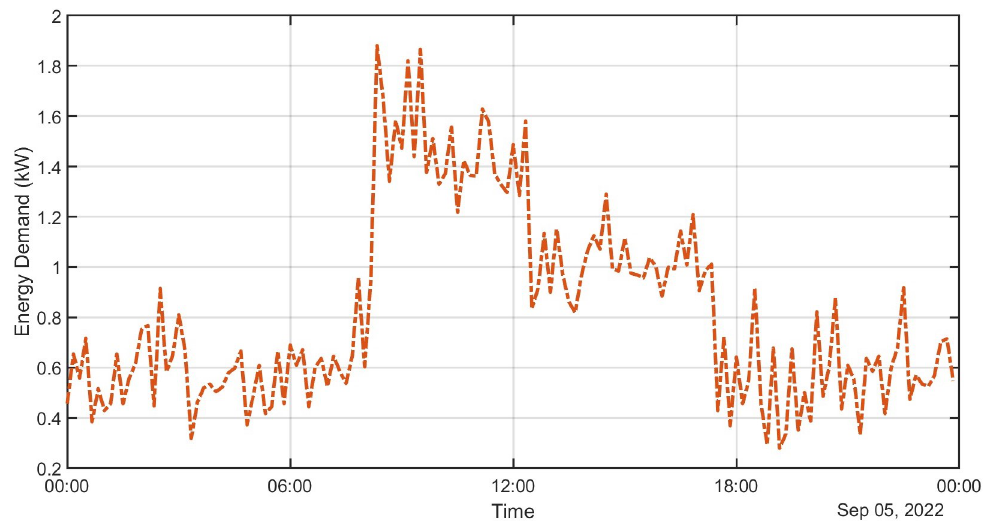
Figure 3. Representation of energy demand for one day.